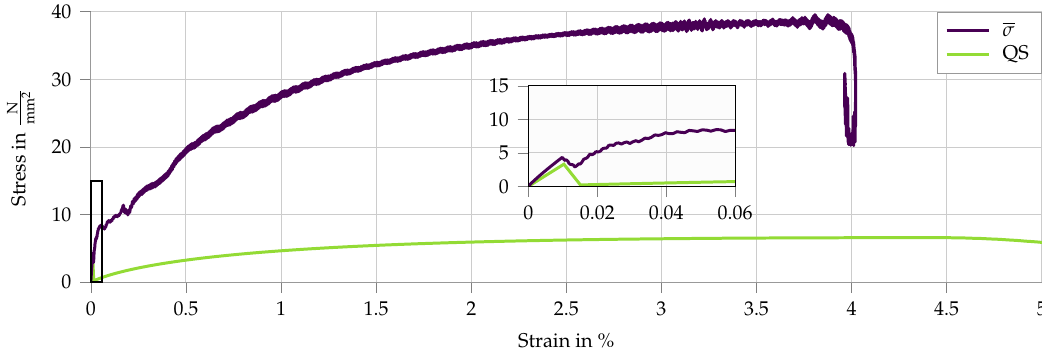
Figure 11. Results of the split Hopkinson tension bar simulation. The average of the stress–strain signals at both interfaces ( σ ) compared to the quasi-static computation (QS). The zoom shows the initial cracking of the matrix.